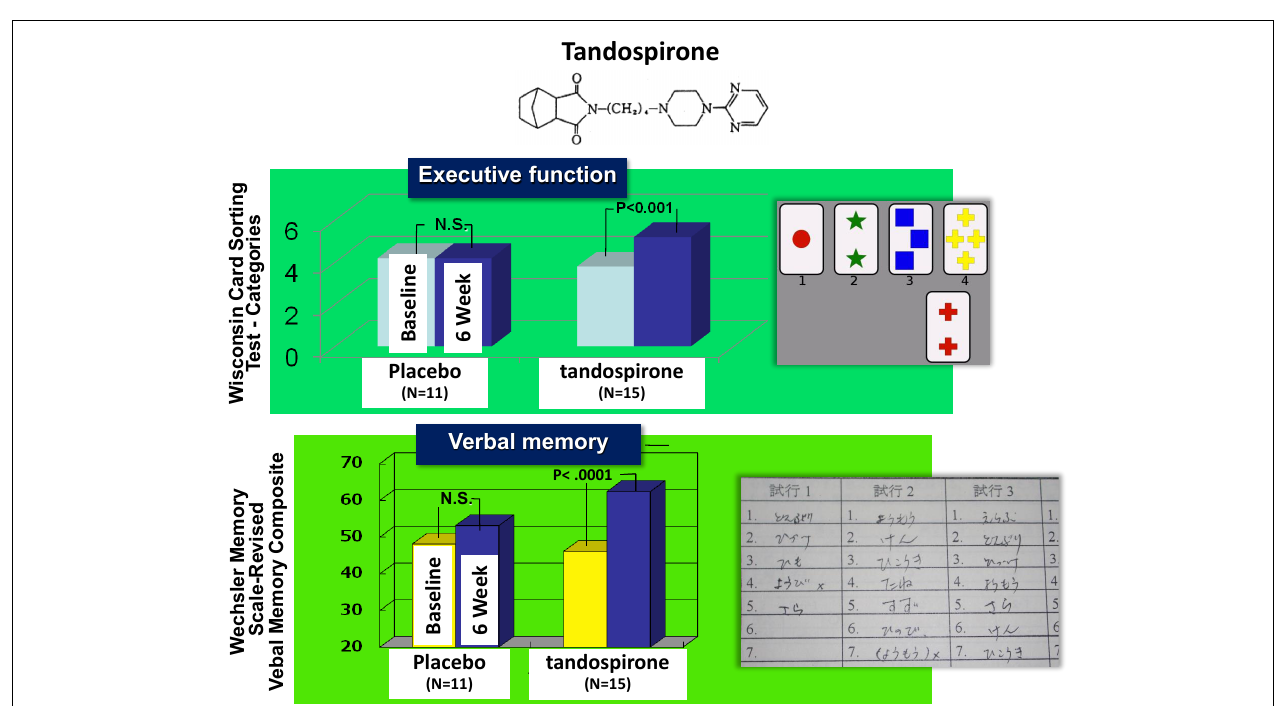
FIGURE 6 | Effect of tandospirone, a 5-HT 1A partial agonist, on cognition in schizophrenia . Six-week treatment with tandospirone, but not placebo enhanced executive function (effect size = 0.63) and verbal memory (0.70), two cognitive domains relevant to functional outcome, in patients receiving haloperidol.